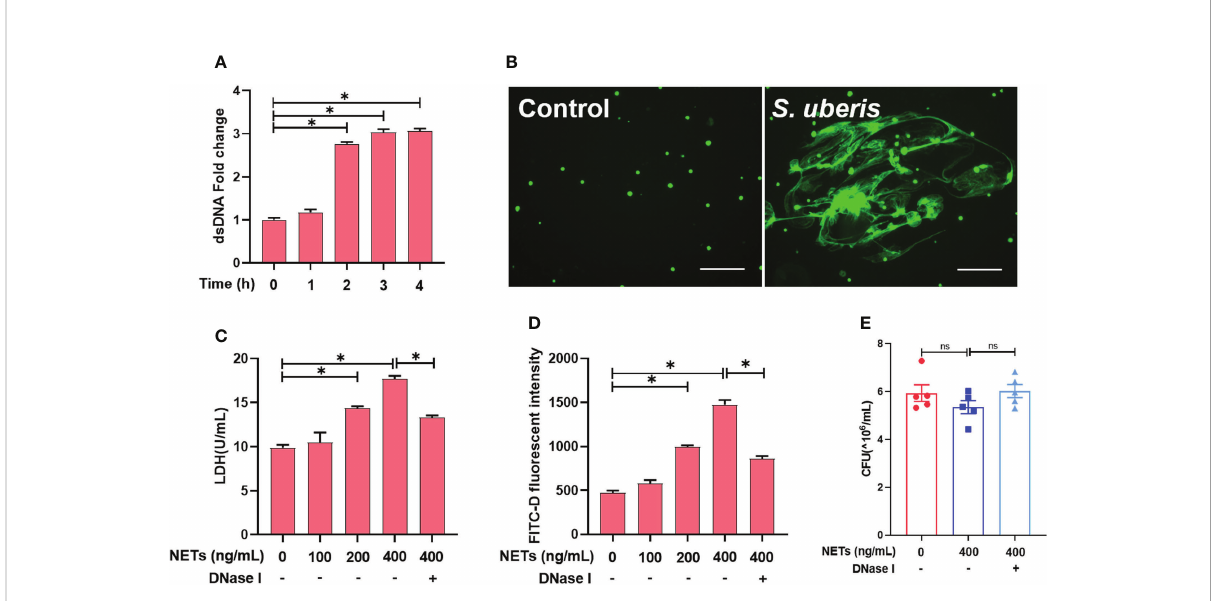
FIGURE 1 S. uberis induce NETs that cause damage to EpH4-Ev cells and mammary epithelial barrier damage. (A, B) Neutrophils were infected with S. uberis at MOI of 10. (A) The extracellular dsDNA content of neutrophils (n = 3). (B) SYTOX Green fl uorescence staining of neutrophil extracellular dsDNA at 4 h after S. uberis stimulation (green) (n = 3). (C, D) EpH4-Ev cell and mammary epithelial barrier were treatment with NETs or DNase І (1.5 mg/mL) for 12 h. (C) LDH activity in EpH4-Ev cells supernatant (n = 3). (D) FITC-dextran (FITC-D) fl ux of mammary epithelial barrier (n = 3). (E) CFU of S. uberis (n = 5). Data are presented as mean ± SEM. * P > 0.05. ns, not signi fi cant (P >